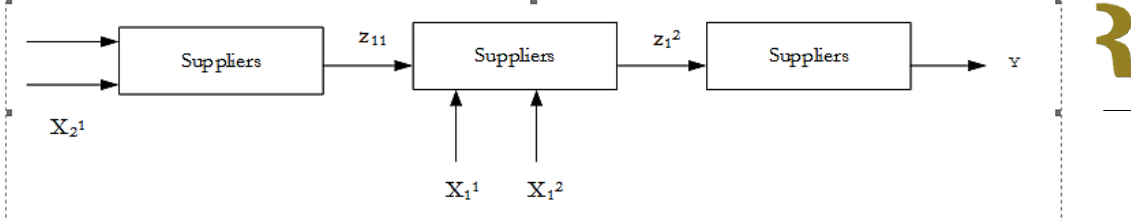
Fig. 3. Supply chain structure.